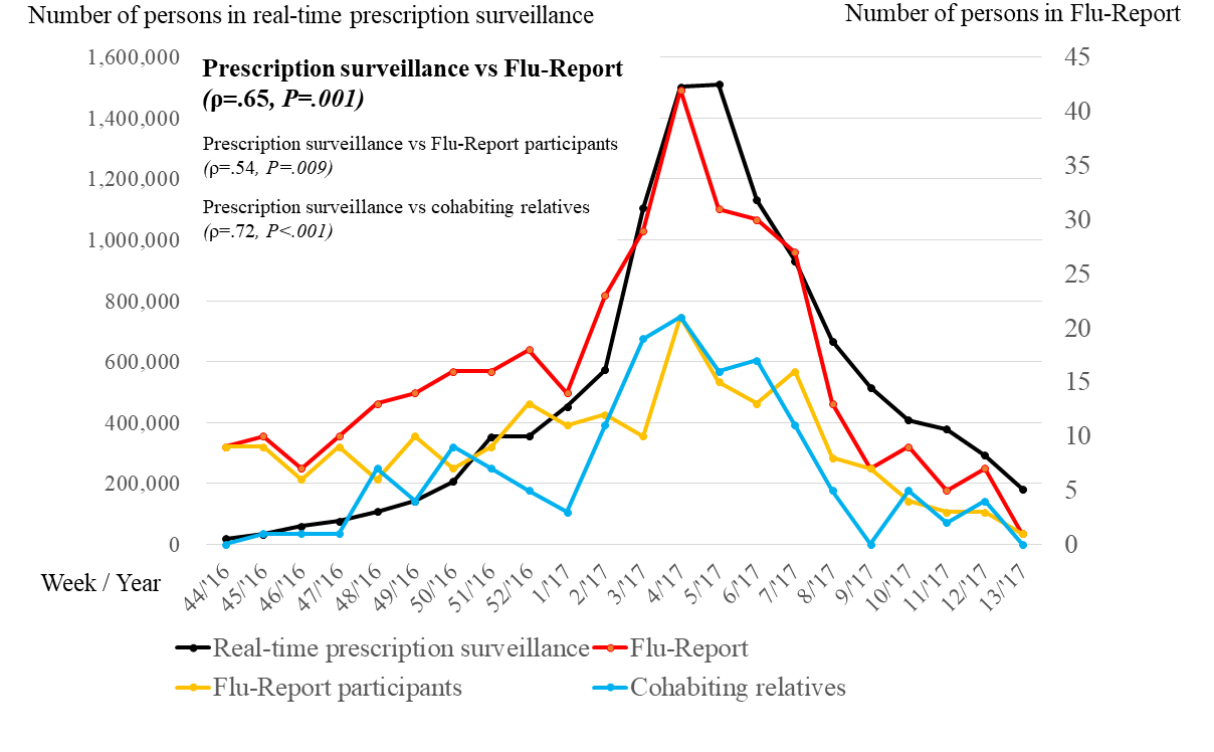
Figure 3. The correlation between Flu-Report data and basic information for the real-time prescription surveillance